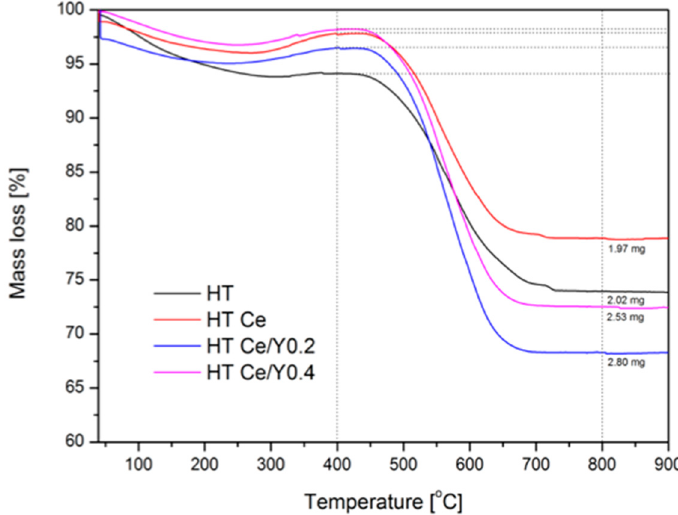
Figure 8. Thermogravimetric analysis (TGA) for the catalysts after isothermal DRM tests.